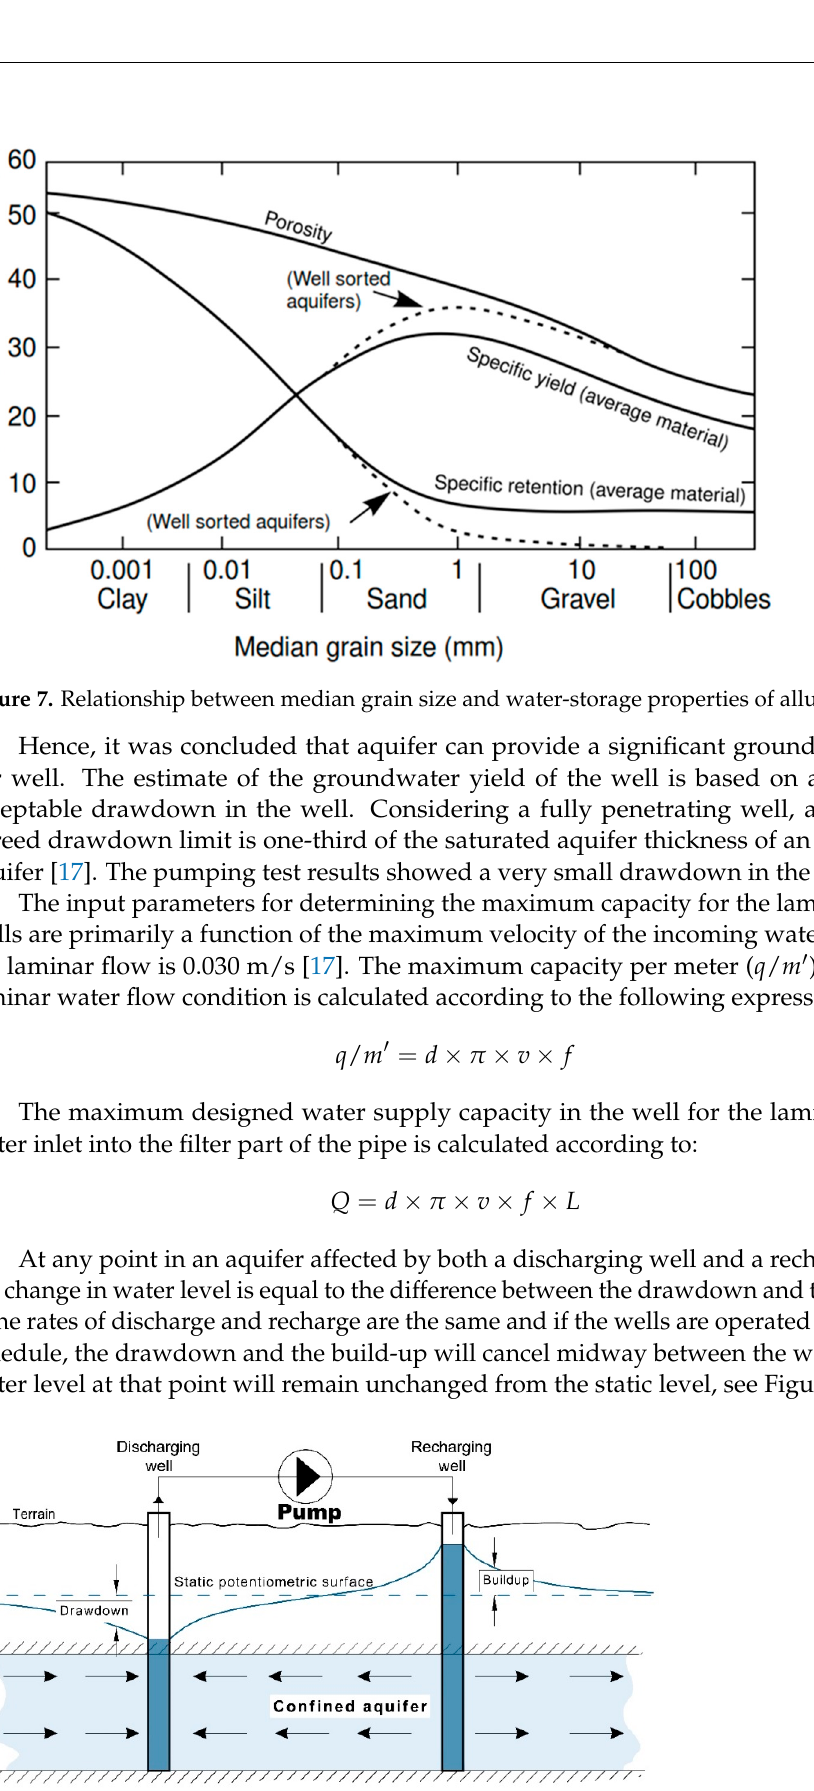
Figure 8. Wells with discharging/recharging quantities and drawdown/build-up from GWL